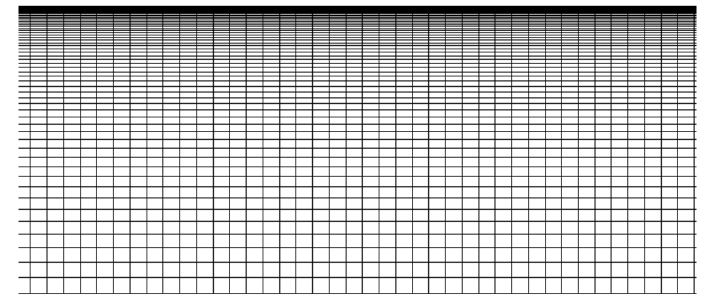
Figure 2. The grid of mesh 2.